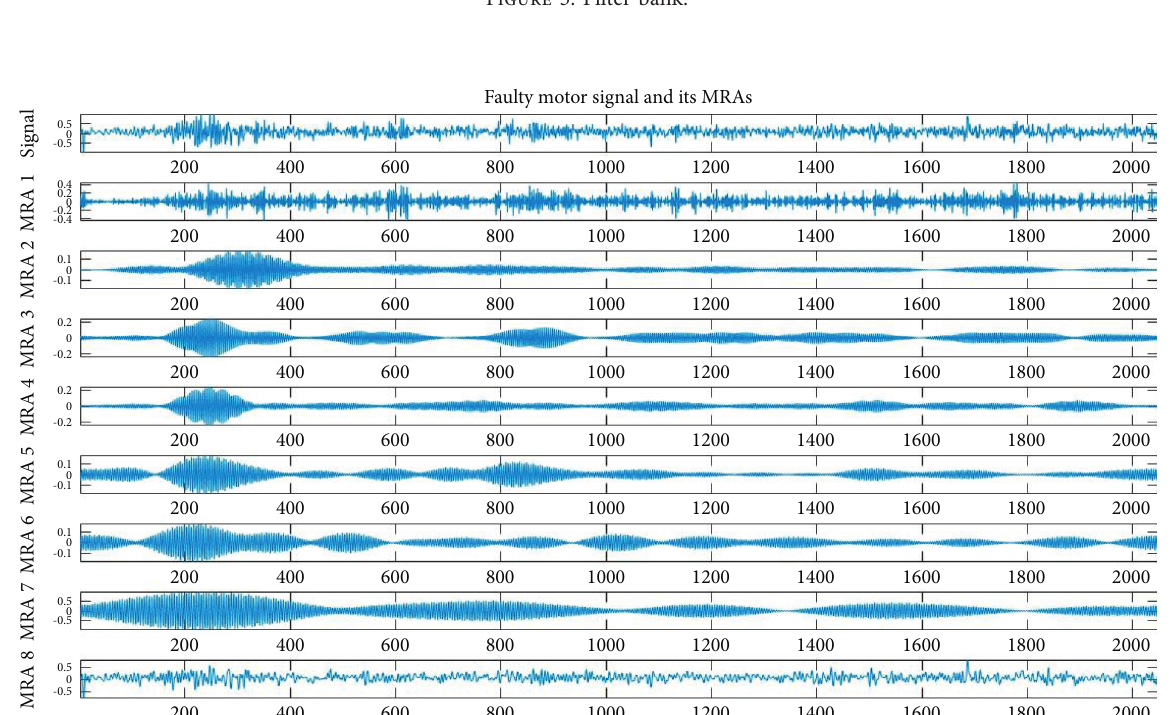
Figure 5: Filter